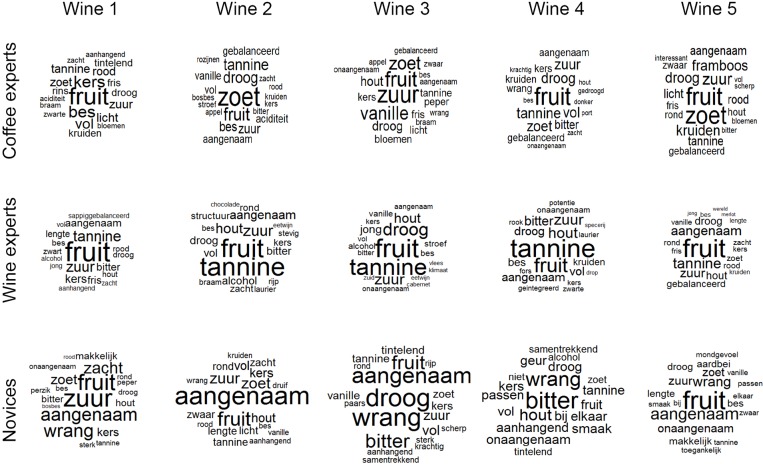
Word clouds of 20 most frequent descriptors for wine flavors.Wine experts agreed on two main qualities: fruit and whether the wine contained tannins. In addition, they identified further distinctive qualities in their descriptions. Novices commented on a number of taste qualities (e.g., zuur ‘sour’, droog ‘dry’, wrang ‘tart’, bitter ‘bitter’), and gave evaluative descriptions (e.g., aangenaam ‘pleasant’).